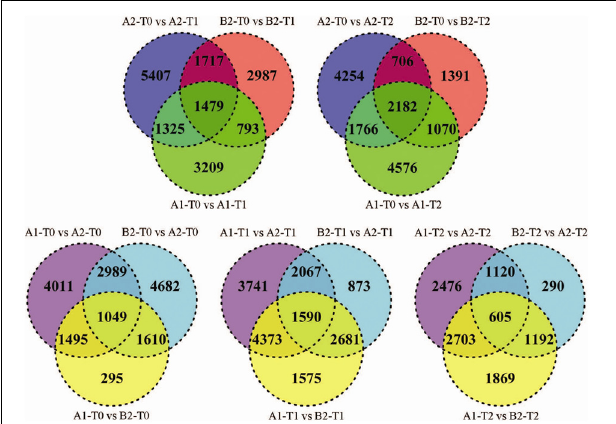
FIGURE 2 | Venn-diagrams for number of significant differences ( p < 10 − 4 ) between tag frequencies in pair wise comparisons. Upper row: comparison of genotype pools A1, A2, and B2 at T0 vs. T1 (left) and T2 (right). Lower row: comparison between genotype pools A1 vs. A2, B2 vs. A2 and A1 vs. B2 at T0 (left), T1 (middle), and T2